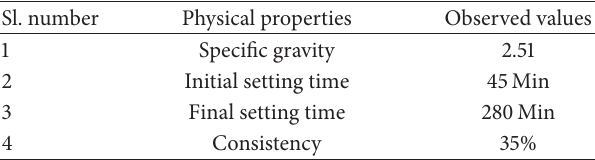
Table 2: Physical properties of fly